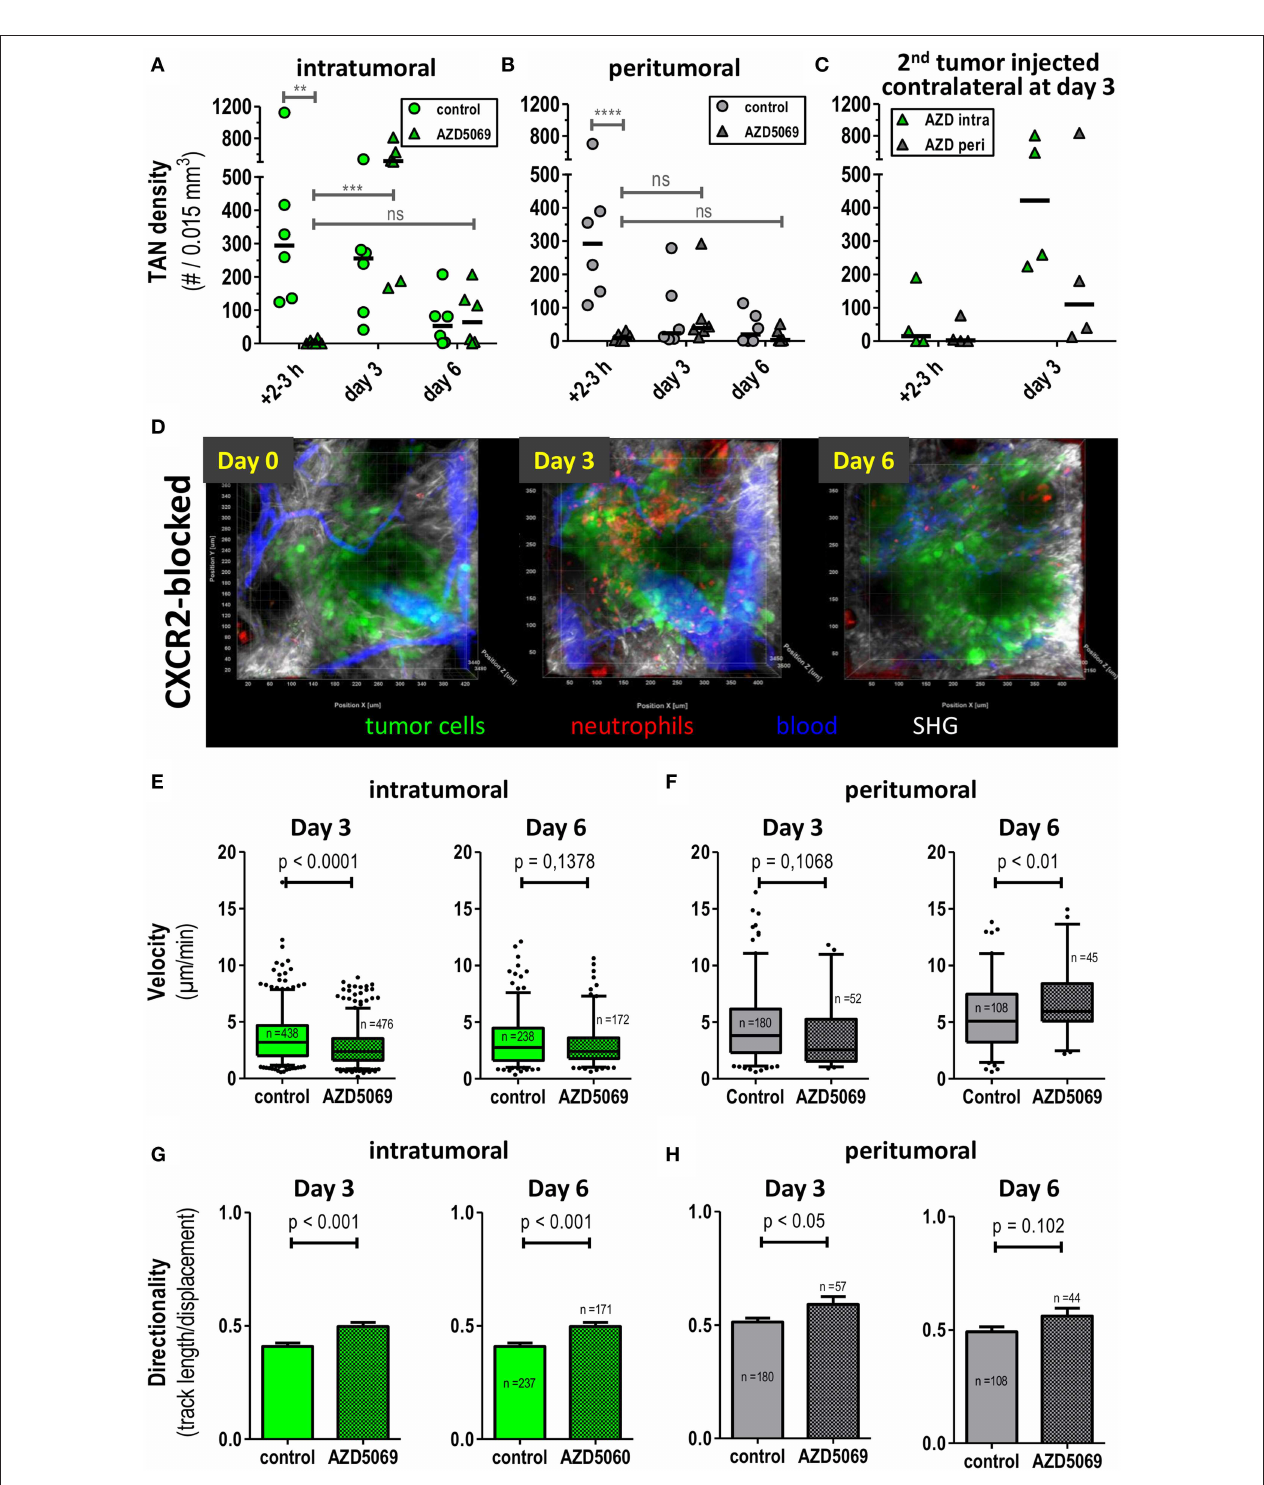
FIGURE 3 | Intratumoral and peritumoral TAN are differentially affected by CXCR2 blockade to AZD5069 treatment. Catchup IVM − red mice were injected with MOPC EGFP cells into the dorsal ear dermis. TAN infiltration and motility was assessed by transdermal intravital 2PM. To block CXCR2 AZD5069 was orally administered twice daily starting from day − 1 before tumor cell inoculation until the end of the experiment. Intratumoral (A) and peritumoral (B) TAN infiltration was quantified as neutrophils per 0.015 mm 3 . Note the efficient reduction of both intratumoral and peritumoral TAN by AZD5069 at day 0. Also note the rebound of intratumoral, but not peritumoral, TAN under AZD5069 treatment at days 3 and 6. (C) Three days after injection of the primary tumor, AZD5069-treated mice received